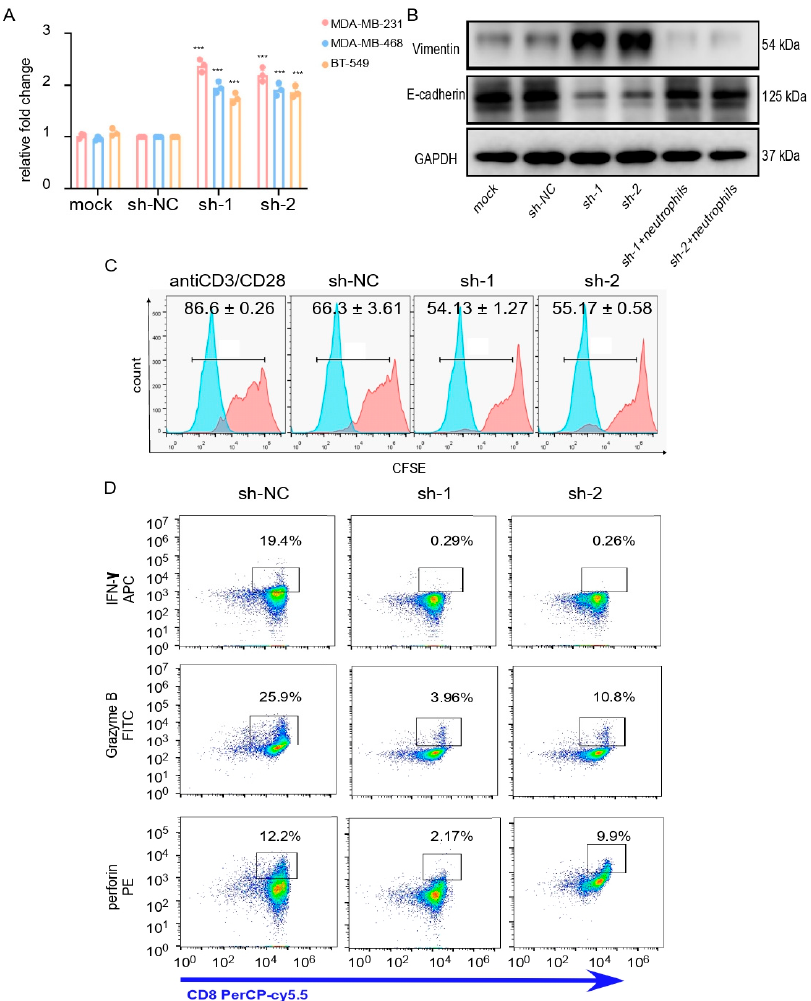
Figure 6. Neutrophil infiltration promotes survival of tumor cells’ lack of CTNND1 expression via impairing cytotoxicity of CTLs. ( A ) Recruitment of neutrophils was detected through CKK8 with neutrophils in the upper chamber (core size 5 µ m) and cells (MDA-MB-231, MDA-MB-468, BT549) with CTNND1 knockdown in the bottom chamber cocultured for 1 h. ( B ) Immunoblotting of EMT markers were detected in EO771CTNND1KD cocultured with neutrophils isolated from bone metastasis of mice with EO771 CTNND1KD . ( C ) Proliferation of CFSE-labeled CTLs was detected by flow cytometry after being cocultured with neutrophils isolated from the bone metastasis of mice for 48 h. mean ± s.d., n = 3. ( D ) Expression of granzyme B, IFN- γ , perforin was detected via flow cytometry in CTLs cocultured with neutrophils isolated from bone metastasis of mice with or without CTNND1 knockdown. *** p < 0.005. Error bars indicate Standard Error of Mean (S.E.M.). 4. Discussion In this study, by way of high-throughput sequencing, we identified CTNND1 down- regulation in TNBC patients with only bone metastasis. Clinically, TNBC patients with lower CTNND1 were associated with a higher rate of bone metastasis and shorter OS, DMFS. In vivo, knockdown of CTNND1 accelerated TNBC cells bone metastasis and the infiltration of immature myeloid cells, especially neutrophils in bone. Mechanistically, knockdown of CTNND1 promoted tumor cells EMT and homing to the bone via upregu- lation PI3K/AKT/HIF-1 α /CXCR4 pathway. When recruited to the bone, tumor cells with